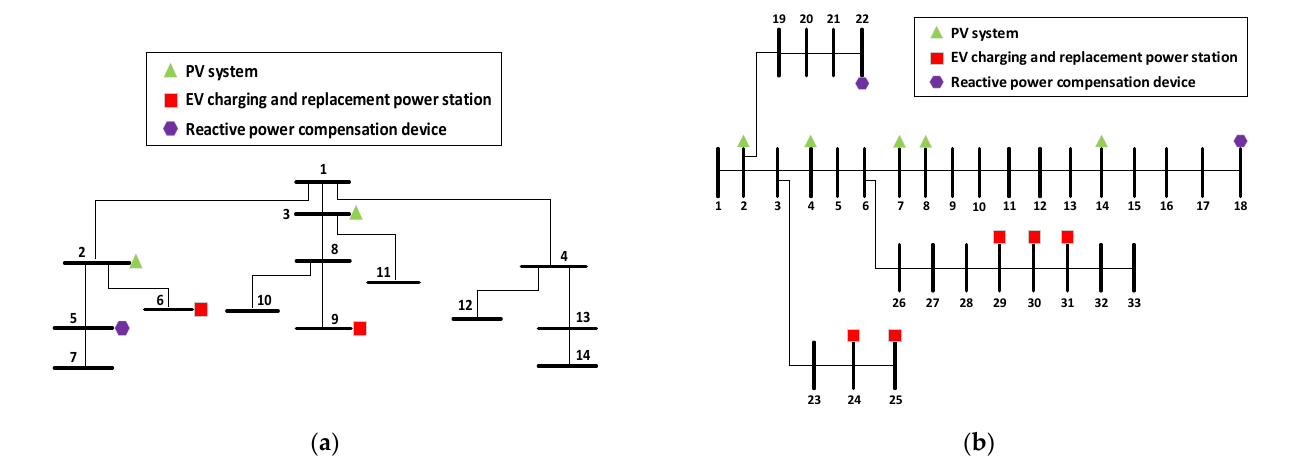
Figure 4. ( a ) Topologies of IEEE 14-bus system; ( b ) Topologies of IEEE 33-bus system. Generally, the main influencing factors of PV output power are current temperature and solar irradiation. Thus, different solar irradiation will be set in different PV to observe its impact on the reactive power regulation range. In addition, each EV charging and replacement station accommodates 10 EVs, and the residual power of each EV is 0–10 kW by considering actual optimal scheduling problem of EVs [40]. The range of total power can be simply added to 0–100 kW. Tables 1 and 2 show the parameters range of PV and EV station in IEEE 14-bus and IEEE 33-bus, respectively. Table 1. Parameters of PV and EV stations in the IEEE 14-bus distribution system.